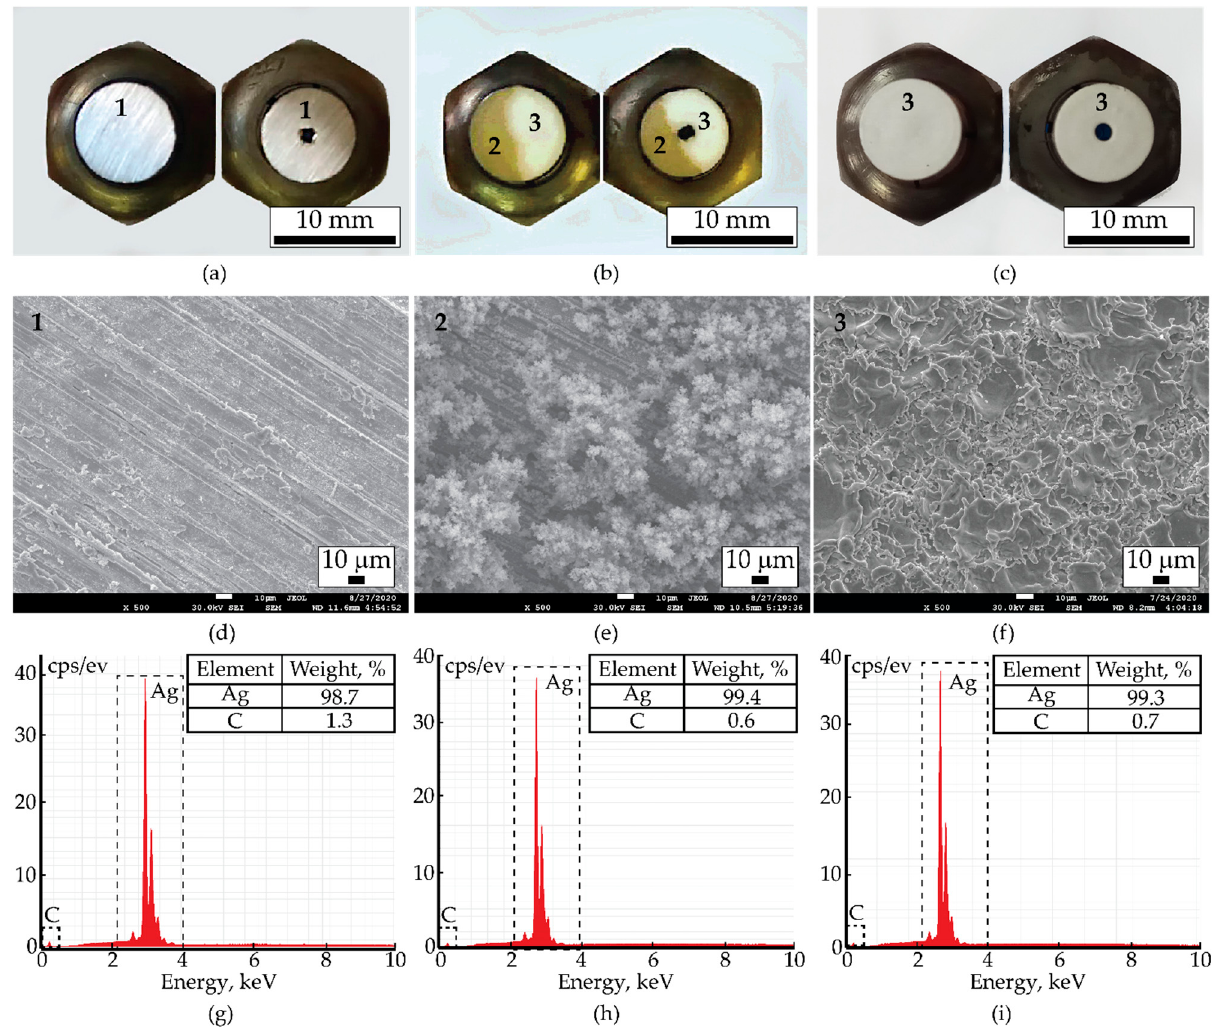
Figure 4. ( a ) Photos of the polished electrodes, ( b ) the electrodes after 6 h of NP synthesis with the ends initially located at the angle of 15° and ( c ) with the initially parallel ends, ( d – f ) SEM images of the corresponding characteristic areas 1, 2, 3, indicated in the photos of the electrode ends, and ( g – i) EDX spectra of Ag electrode surfaces marked 1–3 in ( a – c ).